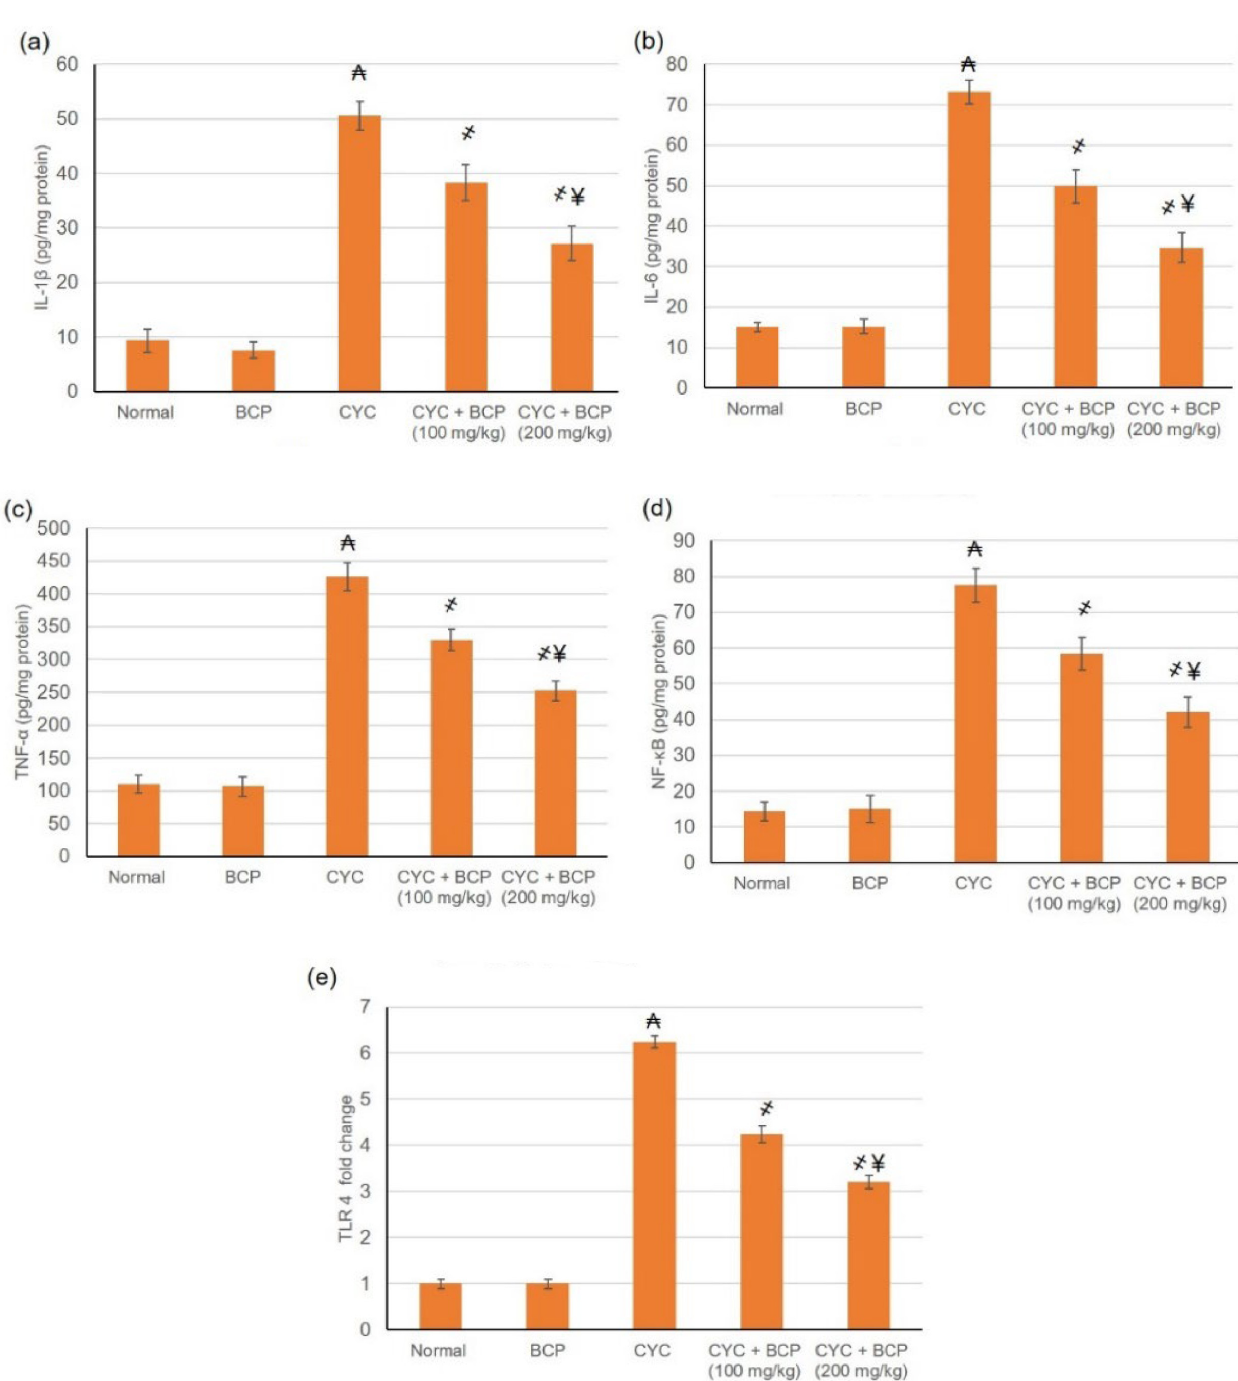
Figure 5. Effects of treatment with β -caryophyllene (BCP) for 14 days on cyclophosphamide (CYC) induced variations on the inflammatory mediators including ( a ) IL-1 β ( b ) IL-6 ( c ) TNF- α , ( d ) NF κ B and ( e ) TLR 4 mRNA in rat. All values are expressed as mean ± SD.